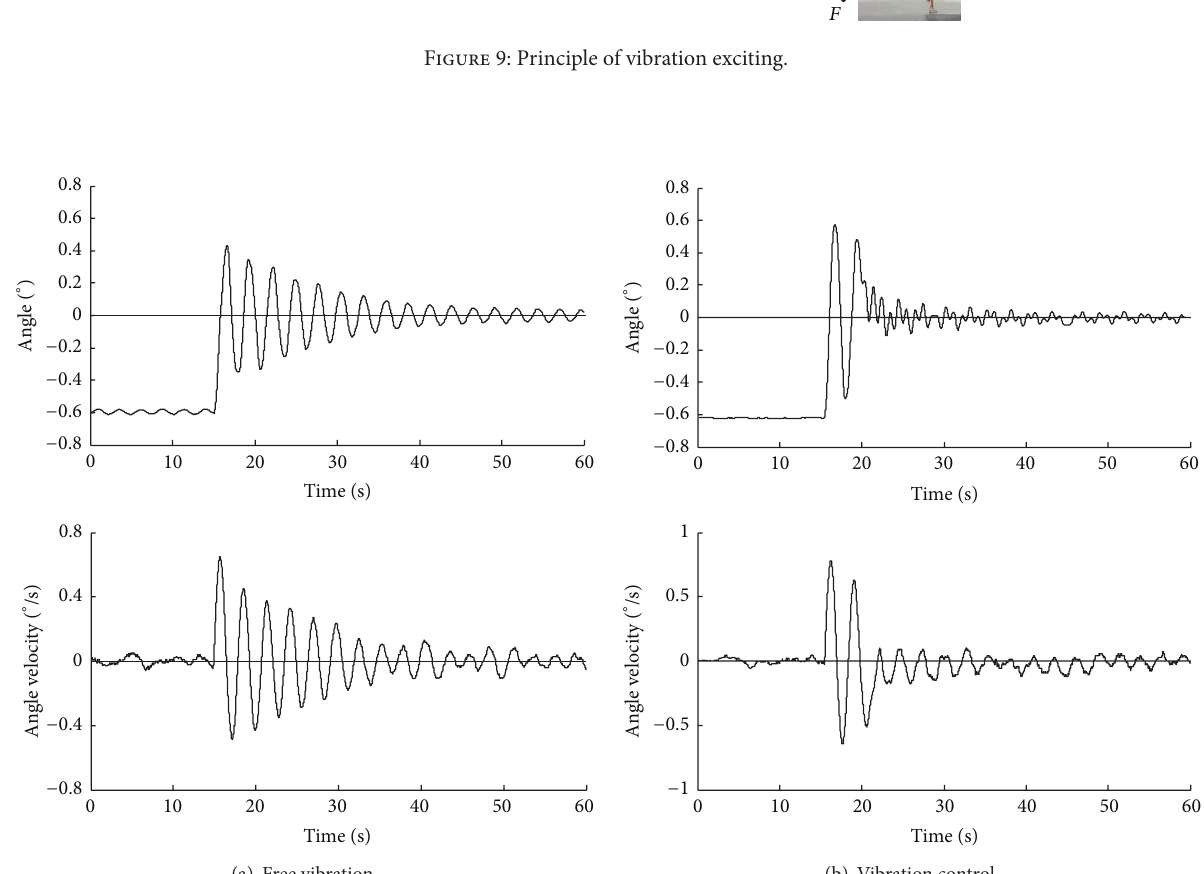
Figure 9: Principle of vibration exciting.